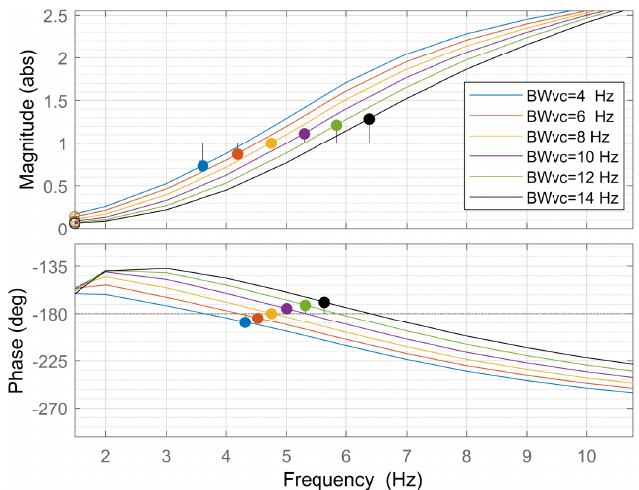
Figure 16. Bode diagram of the system eigenvalue λ 1 for different values of voltage controller band-